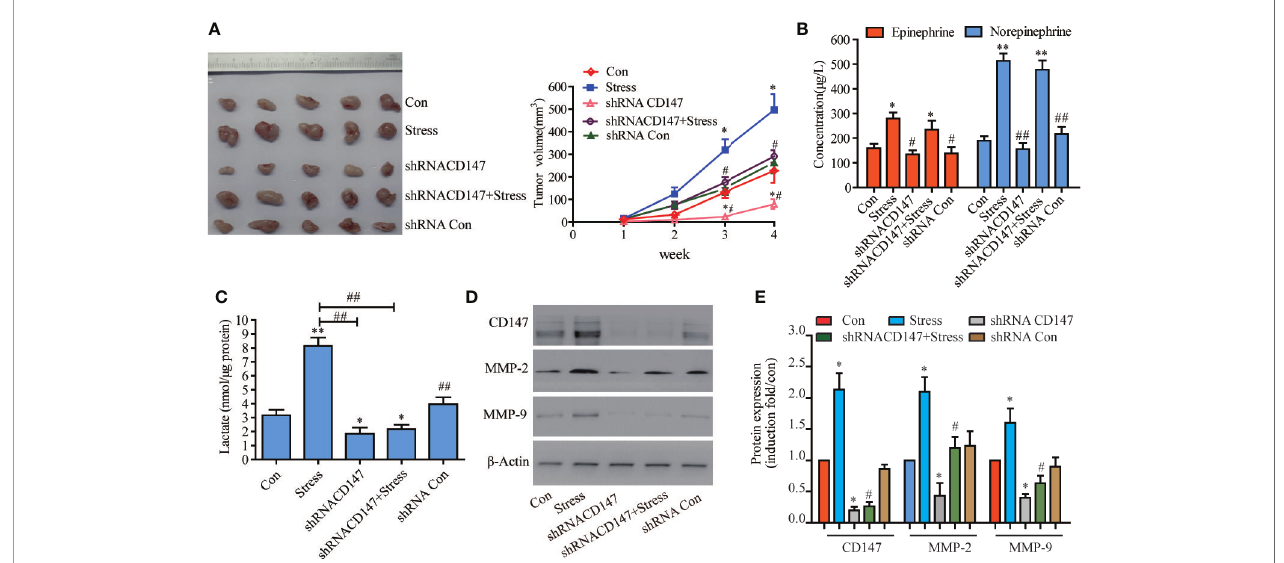
FIGURE 1 | CD147 Silencing Inhibited the Proliferation of Xenograft Tumors Induced by Chronic Psychological Stress in Nude Mice. (A) The growth of transplanted tumors in nude mice (n=5). (B) epinephrine (EPI) and norepinephrine (NE) concentrations in the serum of nude mice with transplanted tumors were detected by ELISA, and the stress hormone levels were not affected after CD147 silencing. (C) Determination of lactic acid in the tumor tissues of nude mice. The expression of CD147, MMP-2, and MMP-9 in tumor tissues of nude mice were detected by western blotting. (D) Evaluated by Western blots and (E) Quanti fi ed. (left to right). CD147, MMP-2, and MMP-9 expression levels were increased in nude mice with glioma and psychological stress treatment. Data are expressed as the mean ± sd. *P < 0.05. **P < 0.01 vs Con. # P < 0.05. ## P < 0.01 vs